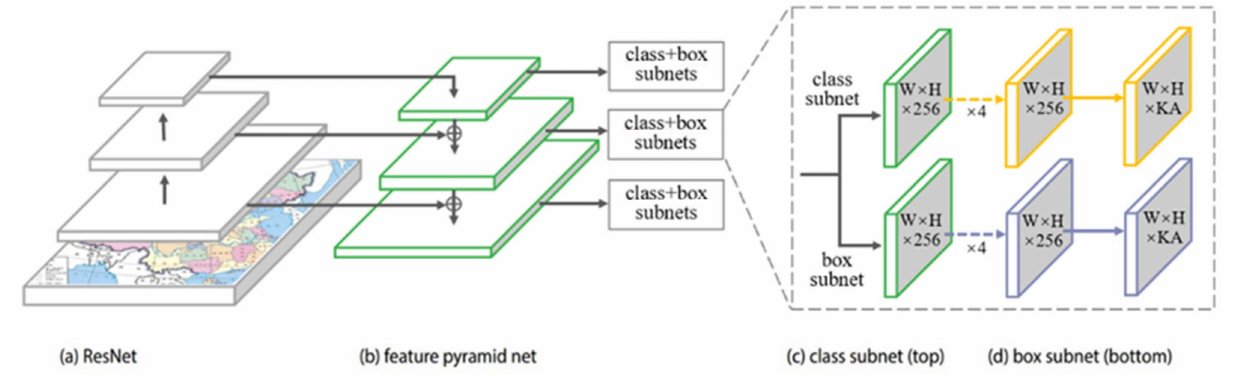
Figure 1. Basic network model structure of